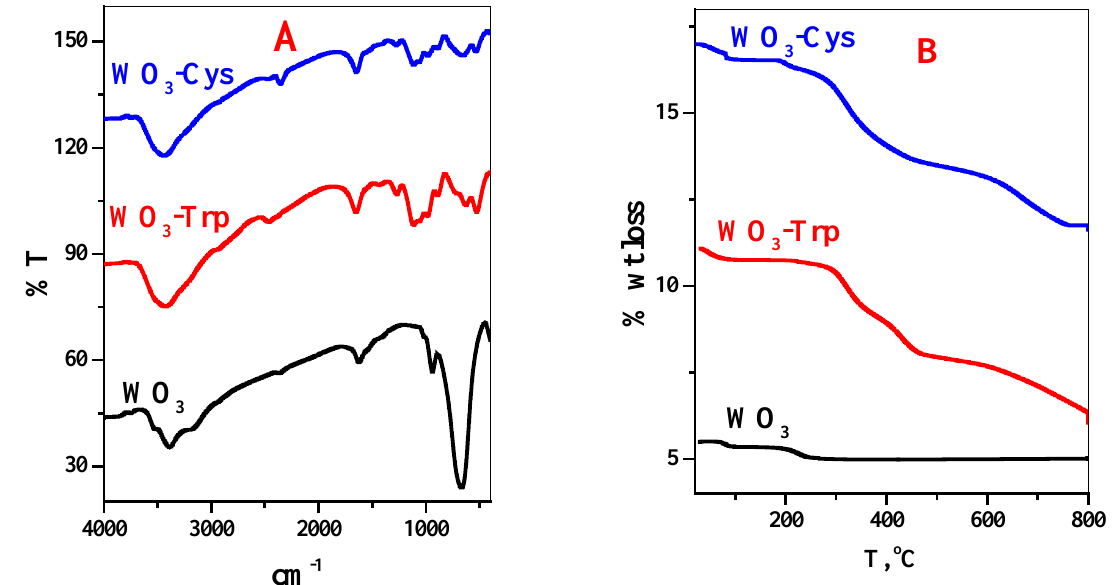
Figure 3. FT-IR spectroscopy ( A ) and TGA analysis ( B ) for the prepared WO 3 NPs with WO 3 -Trp and WO 3 -Cys modified NPs.